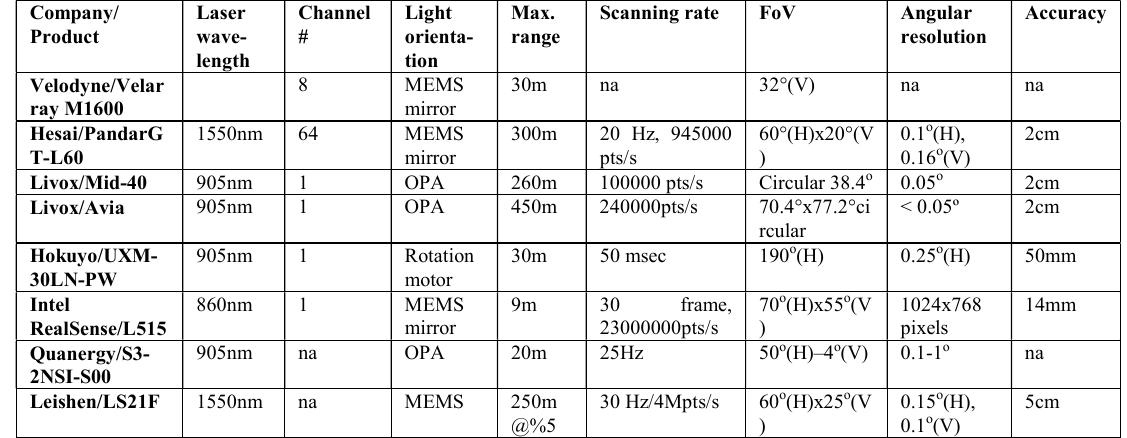
Table 2. Technical specifications of solid-state LiDAR